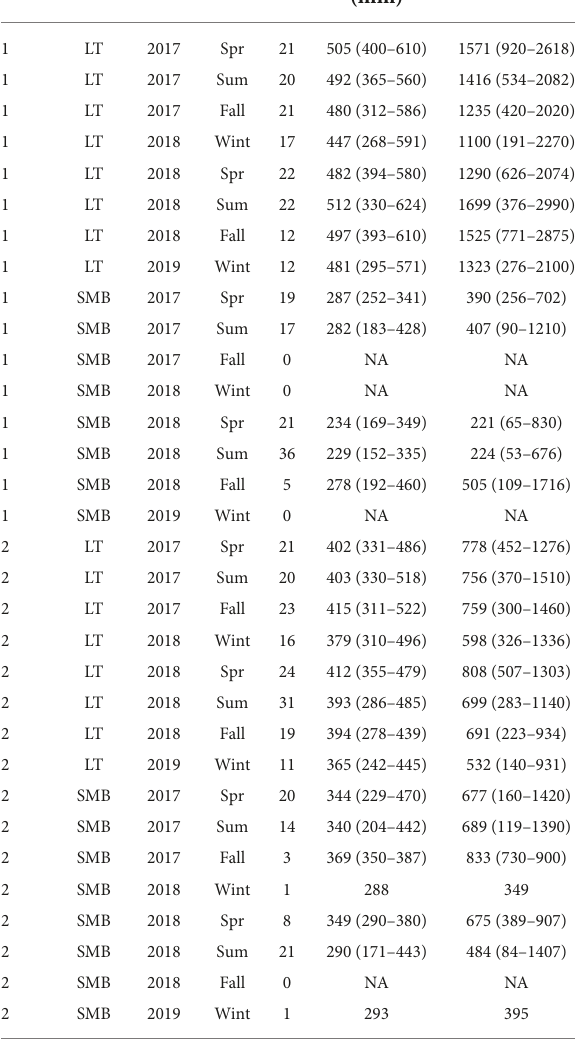
Forklengthandweightarepresentedasmean(min–max). ResultsaredividedbyLake1( + cisco)andLake2( −